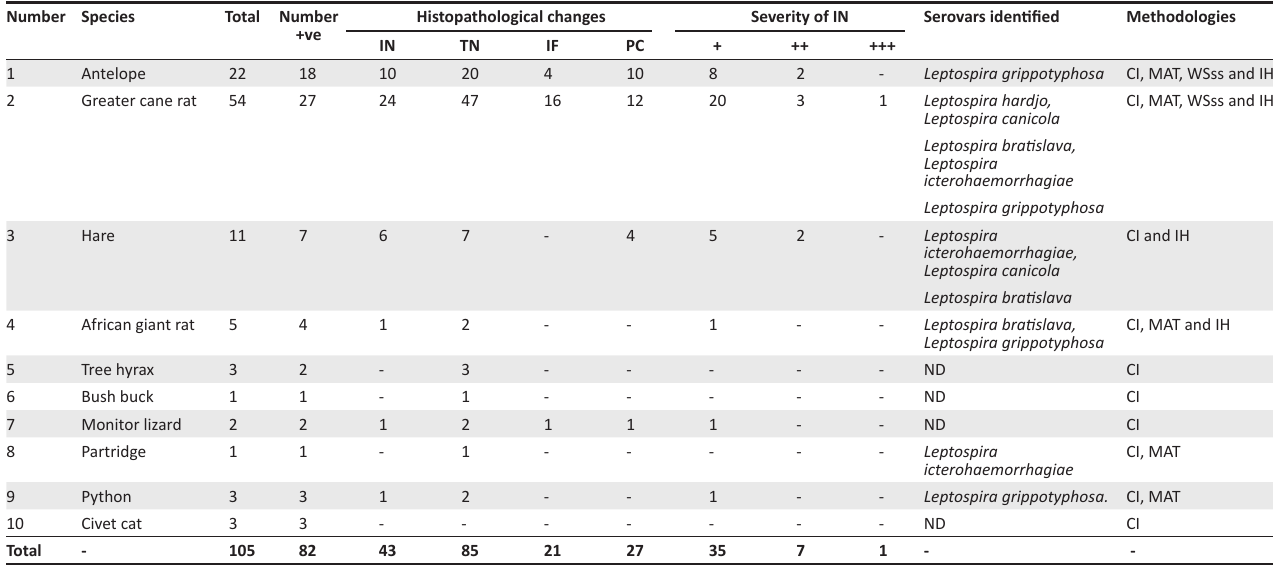
TABLE 6: Summary of the positive samples, histopathological changes, serovars identified and the methodologies used. Number